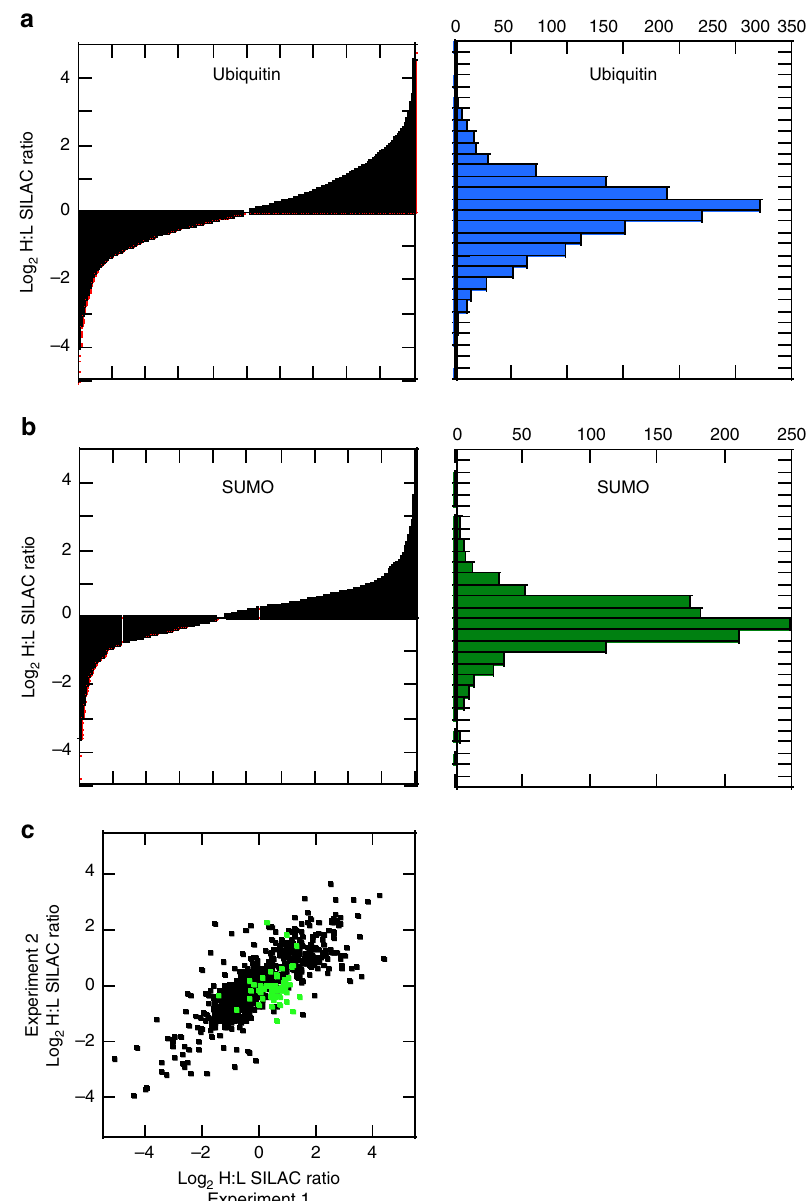
Fig. 4 Parallel identi fi cation and quantitation of the SUMO and Ub-modi fi ed proteome upon MG132 treatment of HCT116 cells. Plot of normalized log(2) SILAC ratios (heavy/light) for all quanti fi ed unique Ub modi fi cation sites a or SUMO modi fi cation sites b upon MG132 treatment. The left graphs depict the ordered distribution of the SILAC ratios and right graphs depict the histogram of SILAC ratios. c Comparison of the SILAC ratios from biological replicates for ubiquitylation sites (black symbols) or SUMOylation sites (green